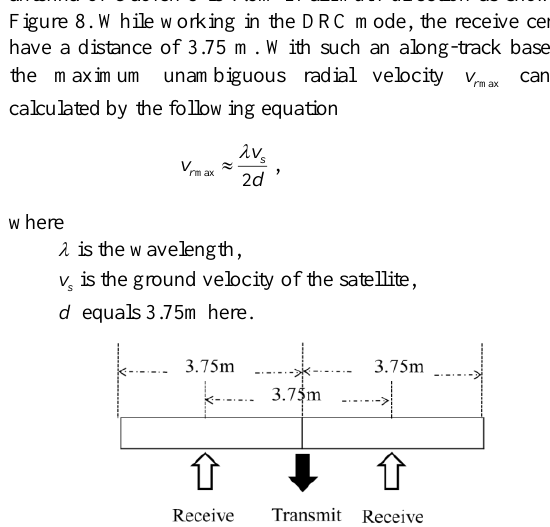
Figure 8. Illustration of the Gaofen-3 DRC mode